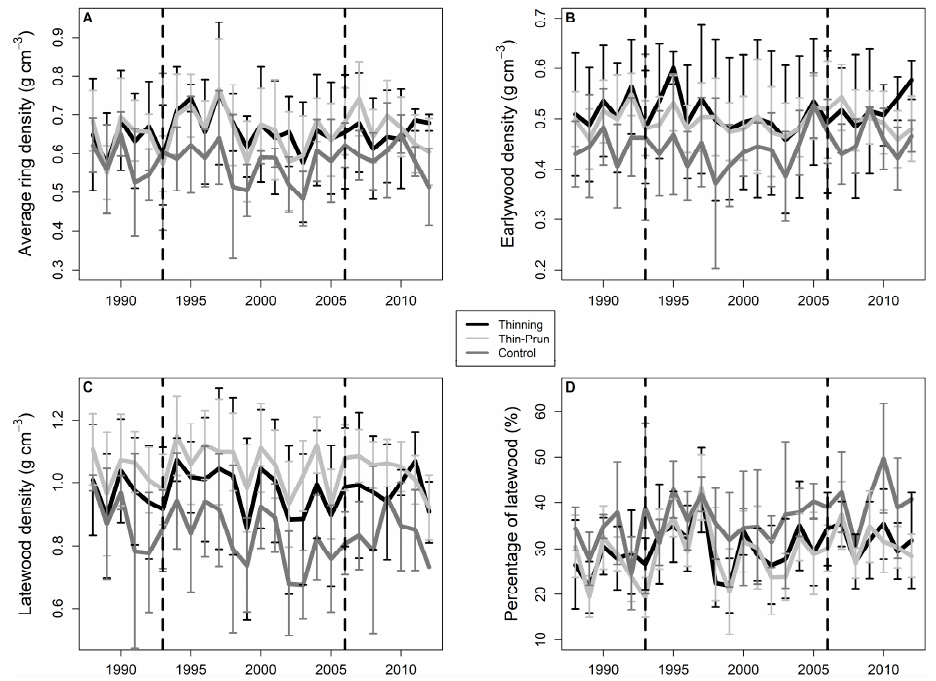
Figure 2. Mean trends ± standard deviation of average ring density ( A ), earlywood density ( B ), latewood density ( C ), and percentage of latewood ( D ) for the treatments in Pinus nigra nigra trial. Vertical dashed lines indicate thinning treatment dates (1993 and 2006).